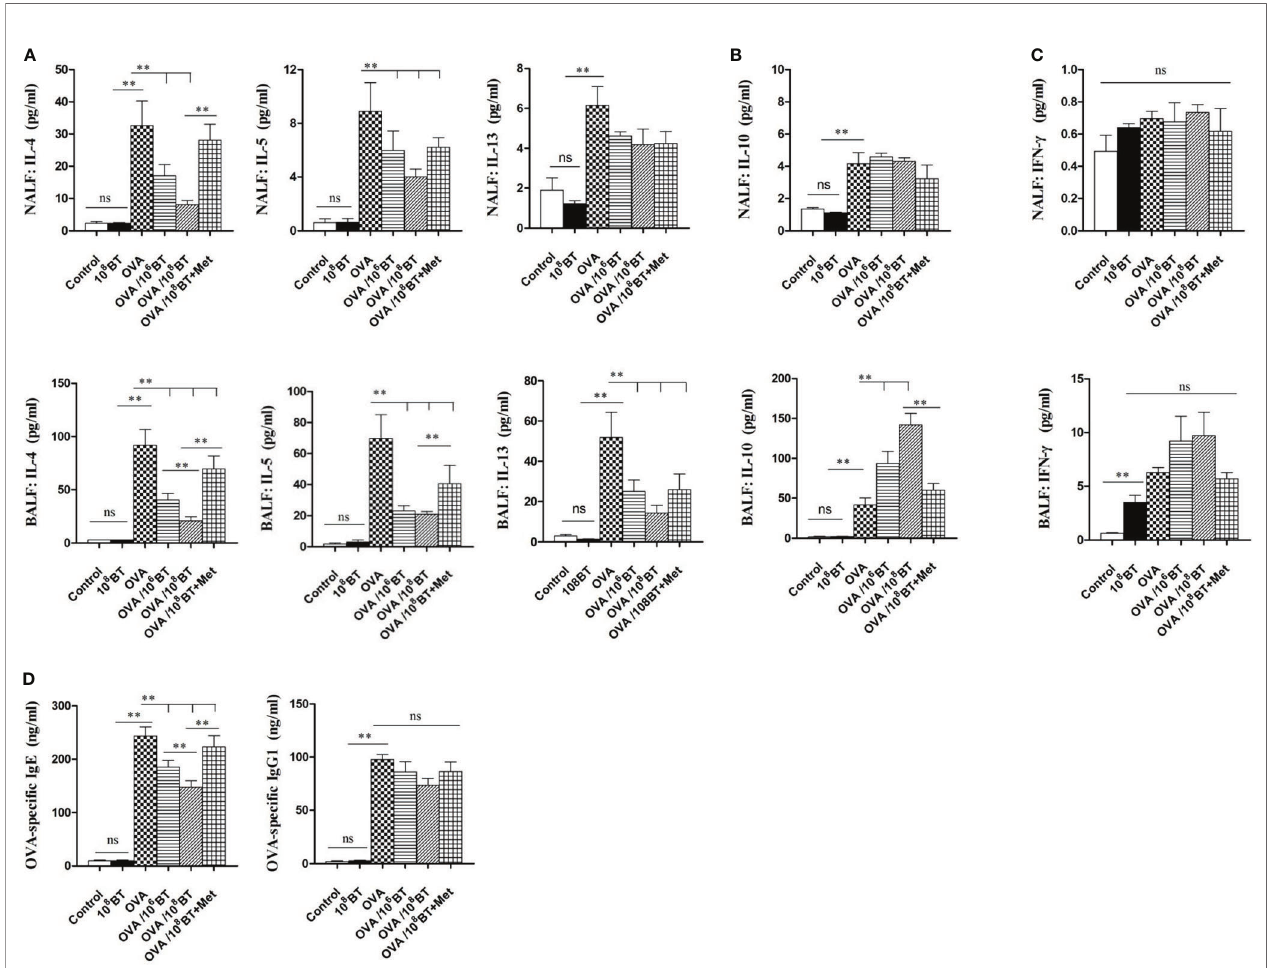
FIGURE 6 | The changes of cytokines IL-4, IL-5, IL-13 (A) , IL-10 (B) and IFN- g (C) in NALF and BALF and serum OVA-speci fi c IgE and IgG1 levels (D) . Oral B. thetaiotaomicron application inhibited secretion of Th2 cytokines IL-4, IL-5 and IL-13 and increased levels of IL-10 in BALF. Levels of Th1 cytokine IFN- g in the lavage liquid were not signi fi cantly changed. Oral B. thetaiotaomicron application also reduced serum OVA-speci fi c IgE production induced by OVA challenge signi fi cantly, but not IgG1 production.** P < 0.01. ns, no signi fi